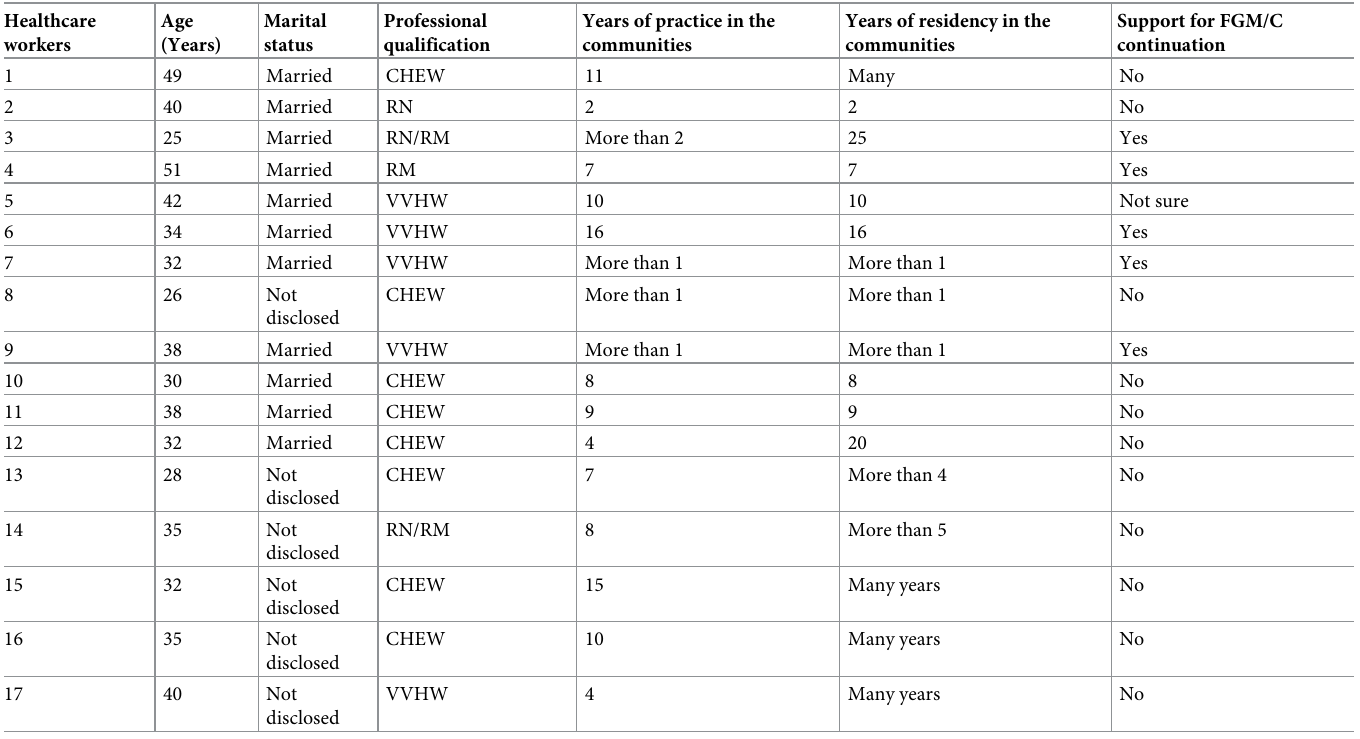
Table 1. General information of the participants.